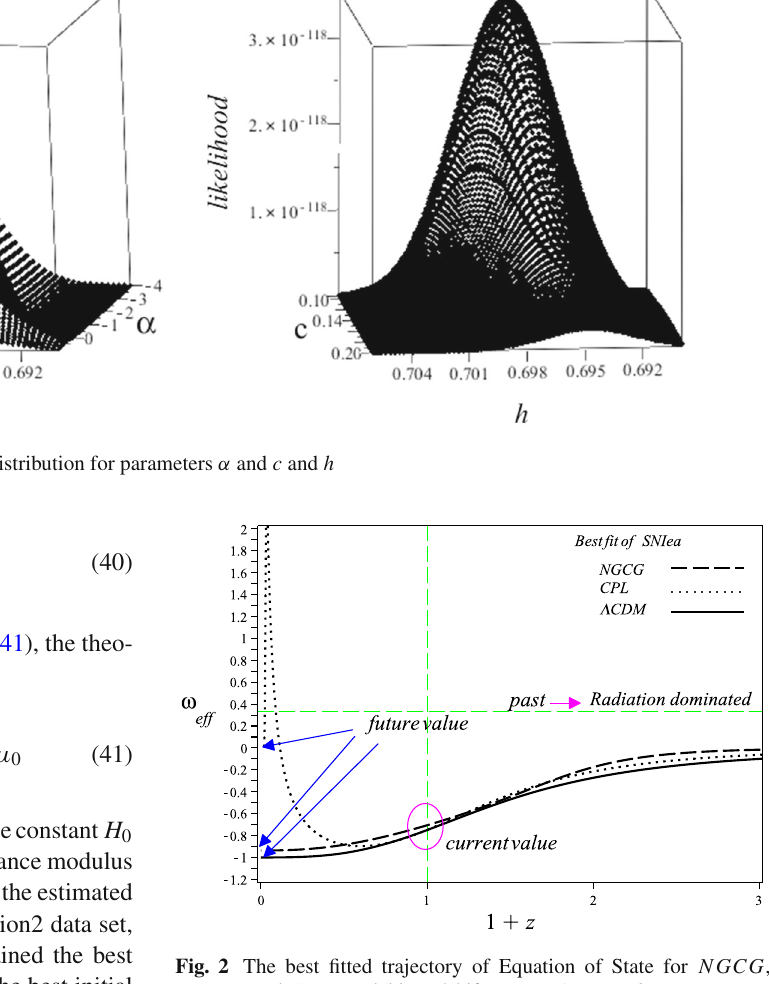
In Fig. 3 cosmographical parameters have been plotted for bestfittedparameters c , α anddifferentinitialconditions.The red dash line shows the plot for best values of α and c and best fitted initial